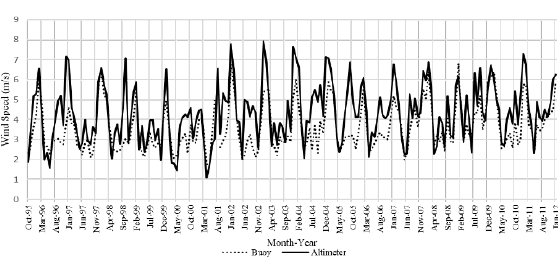
Figure 5. Time-series graph of inter-comparison altimeter and buoy for point located at Sarawak Sea for monthly average.